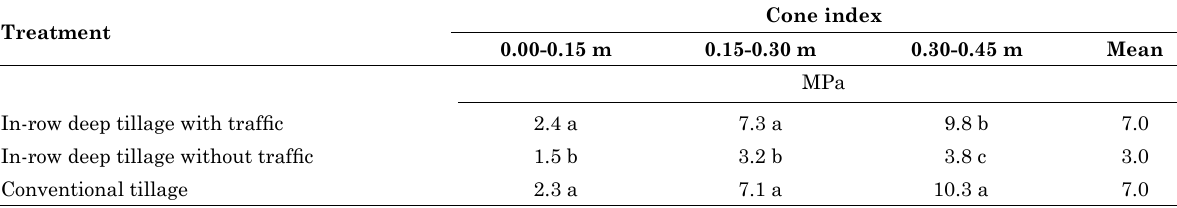
table 4. Soil cone index of treatments in different layers after sugarcane harvest treatment